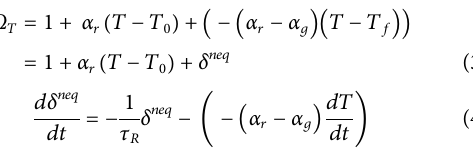
FIGURE 2 One-dimensional rheological representation of the thermoviscoelastic